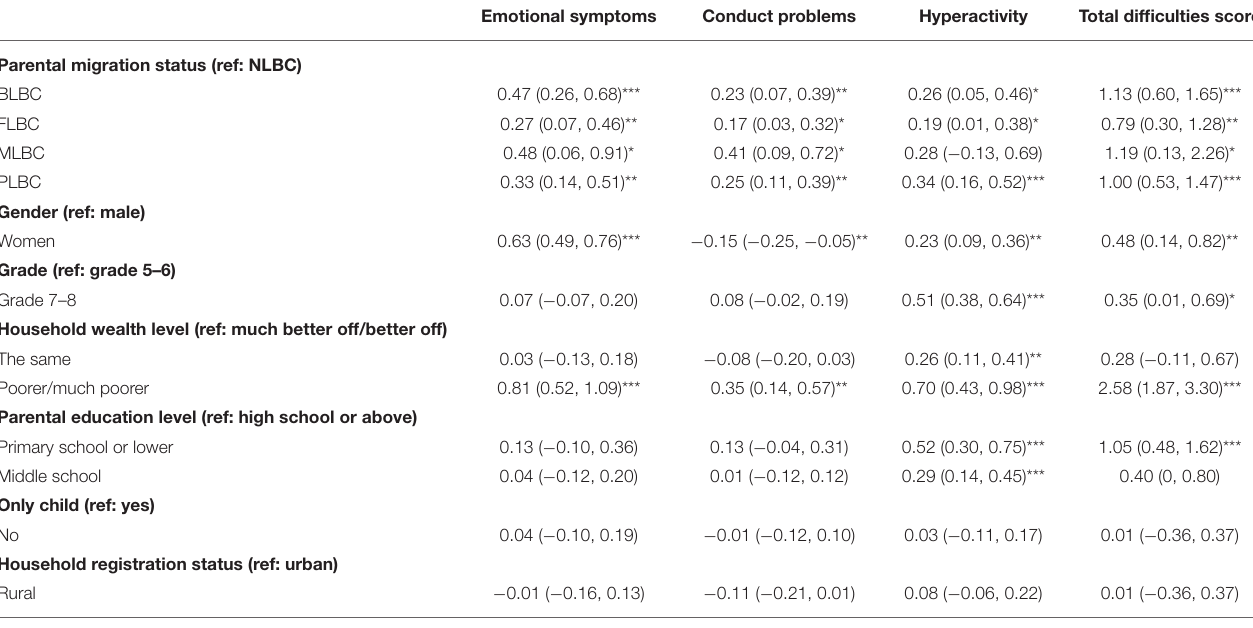
TABLE 4 | Linear regression analysis for SDQ by parental migration groups and demographic characteristic, β (95% CI). Emotional